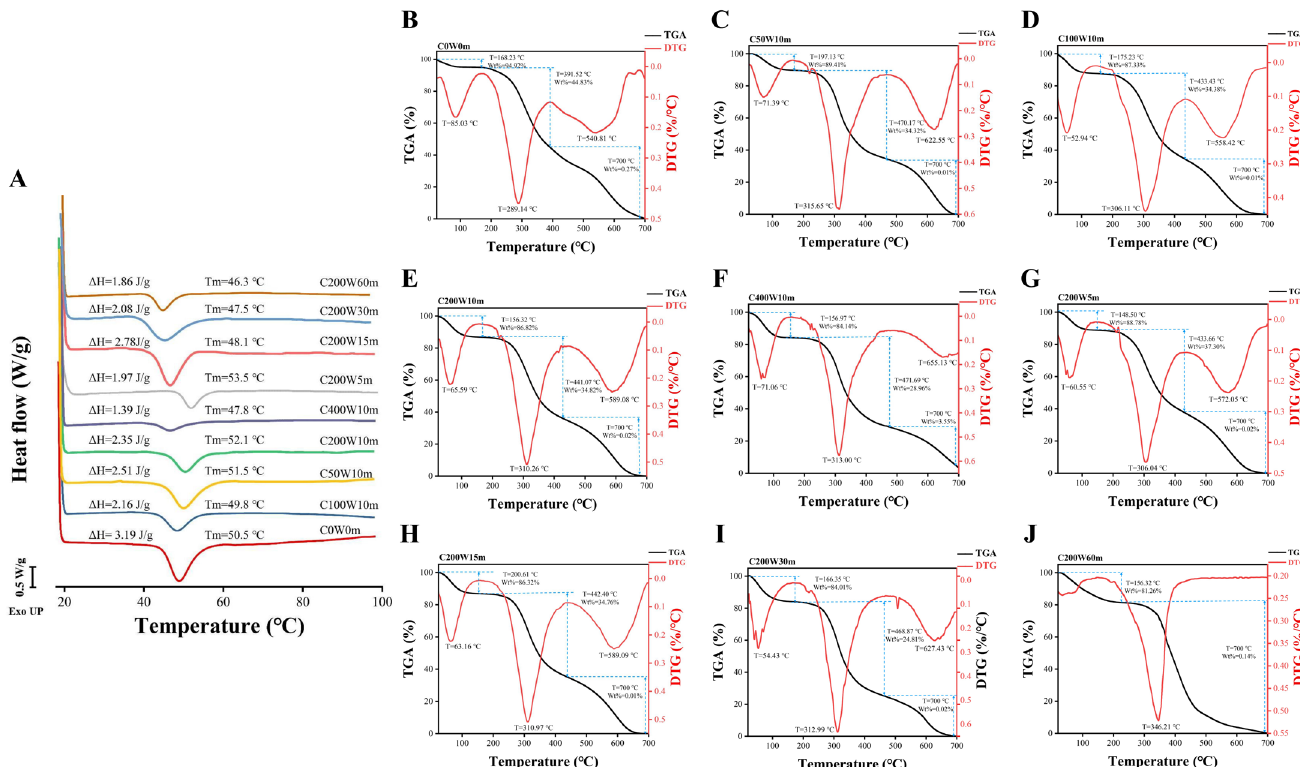
Figure 5. Differential scanning calorimetry curves of collagen fibril gels at 20 – 100 °C ( A ); thermogravimetric curves (TGA) and its first derivatives (DTG) of C0W0m ( B ), C50W10m ( C ), C100W10m ( D ), C200W10m ( E ), C400W10m ( F ), C200W5m ( G ), C200W15m ( H ), C200W30m ( I ) and C200W60m ( J ).